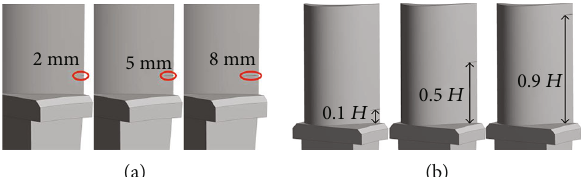
Figure 11: Turbine blades with through-thickness cracks. (a) The through-thickness cracks with di ff erent lengths. (b) The through-thickness crack with di ff erent positions.